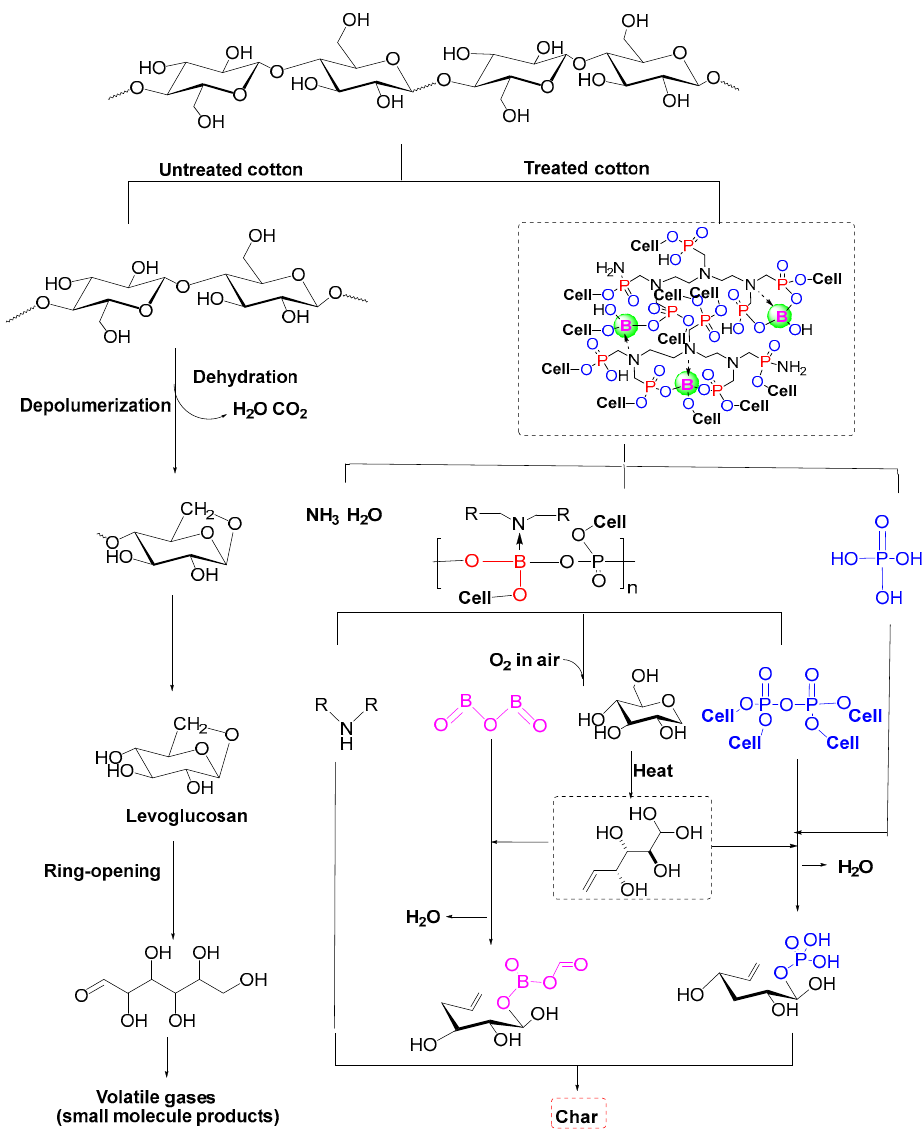
Figure 10. Possible pyrolysis routes of BDA ‐ treated cotton